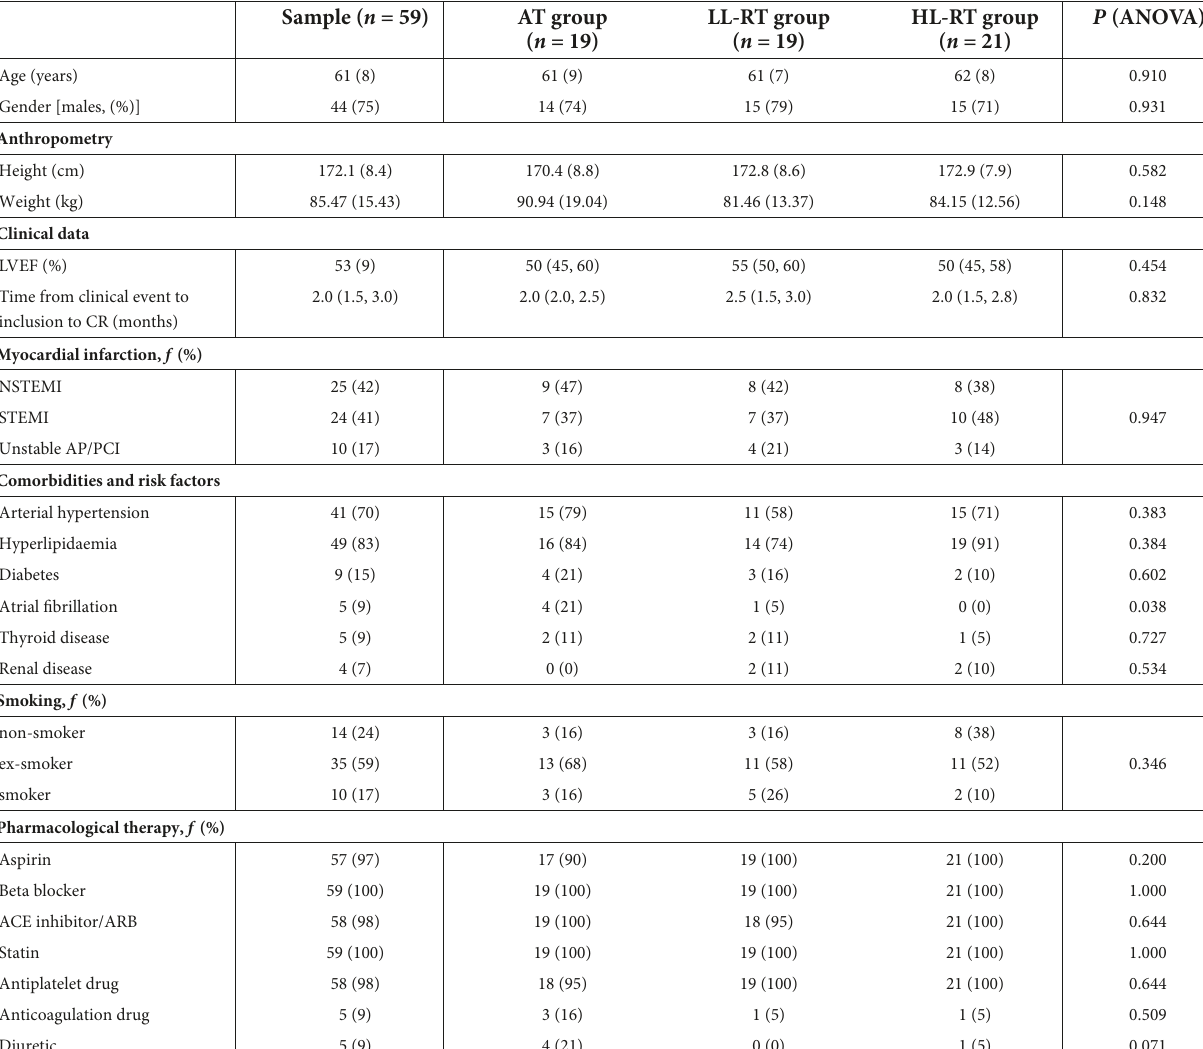
TABLE 1 Baseline anthropometry, clinical characteristics, and cardiovascular risk